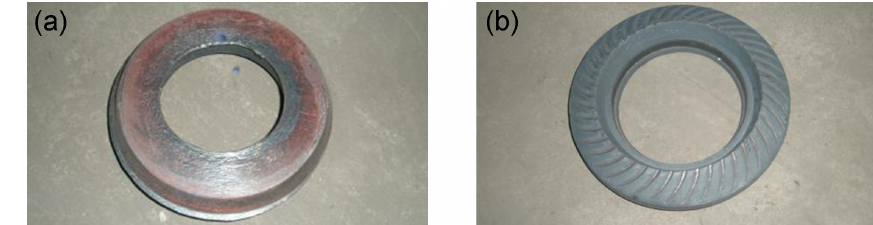
Figure 18. Product. (a) ω 1 (cid:54)= ω 2 and ω 1 · ω 2 > 0, (b) ω 1 (cid:54)= ω 2 and ω 1 · ω 2 <